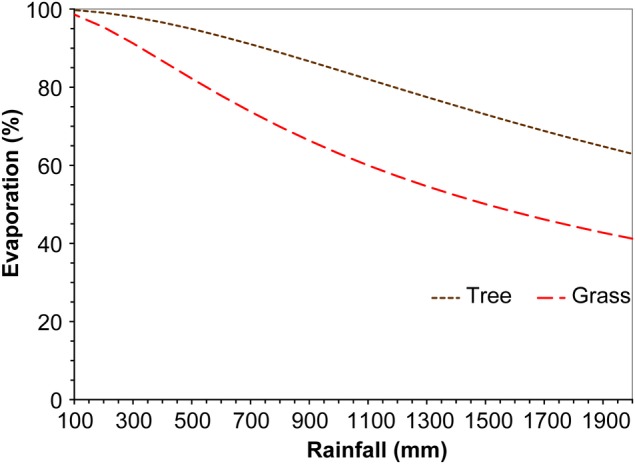
Generalized relationships between mean annual rainfall and mean annual evaporation (as a percentage) for catchments with two differing dominant vegetation types: grasslands, mainly seasonal pastures or trees (woodlands or forest). The evaporation data represent dryland settings as riparian zones comprise a small proportion of most catchments (1–5 % and up to 10 % in some cases) or had vegetation which did not change when the rest of the catchment was converted from tree to grass cover. Derived from data in Zhang et al. (1999, 2001).